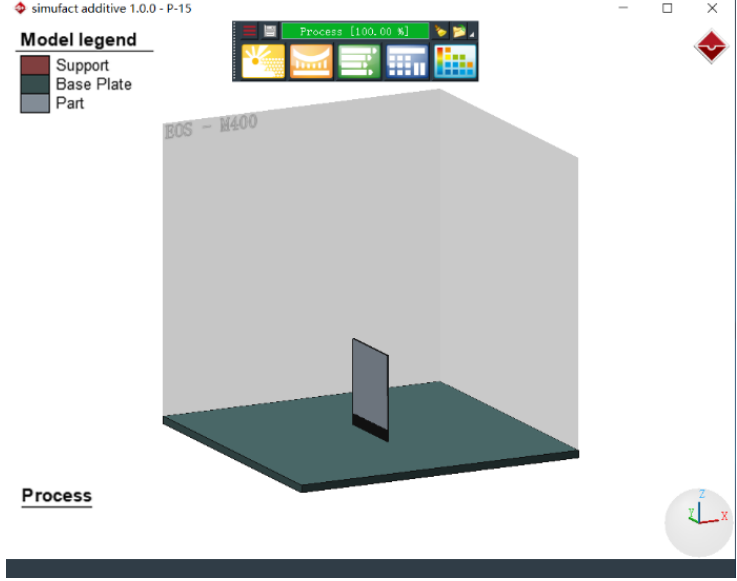
Fig. 1 Interface of Simufact